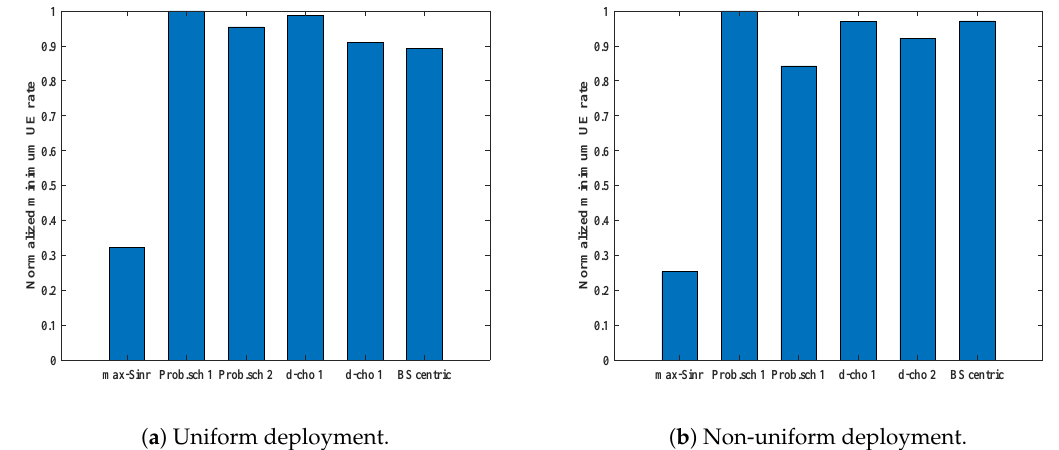
( a ) Uniform deployment. ( b ) Non-uniform deployment. Figure 8. Normalized minimum rate for different association schemes in different deployment scenarios.